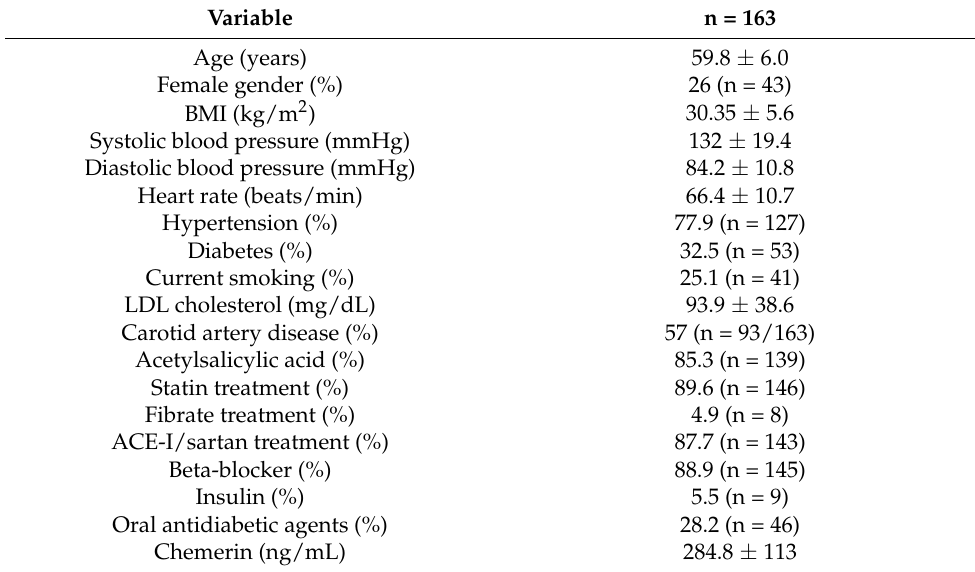
Table 1. Baseline characteristics of the study group.